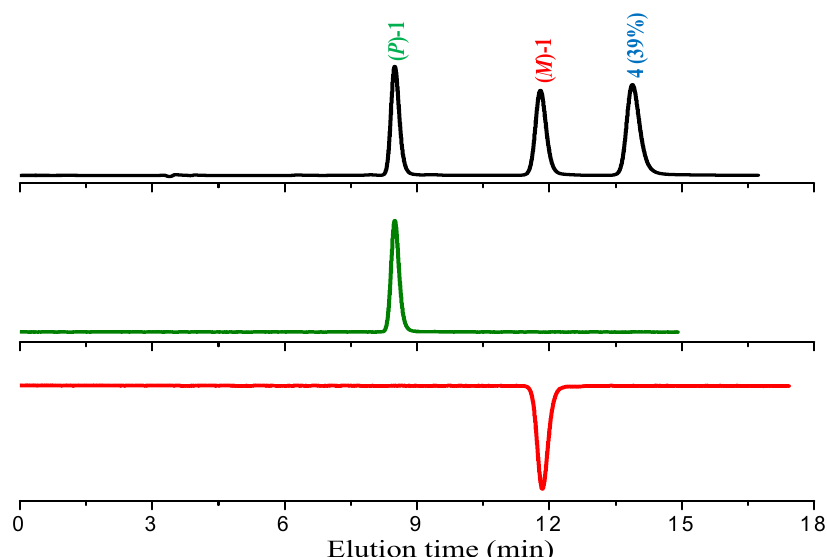
Figure 2. HPLC resolution of ( ± )-5-aza[6]helicene ( 1 ) and simultaneous purification from by-product 4 . Column: Chiralpak IA 250 mm × 4.6 mm, mobile phase: n -hexane-isopropanol-ethyl acetate- diethylamine 100/5/5/0.2, flow rate: 1 mL/min, detector: UV/CD at 325 nm.